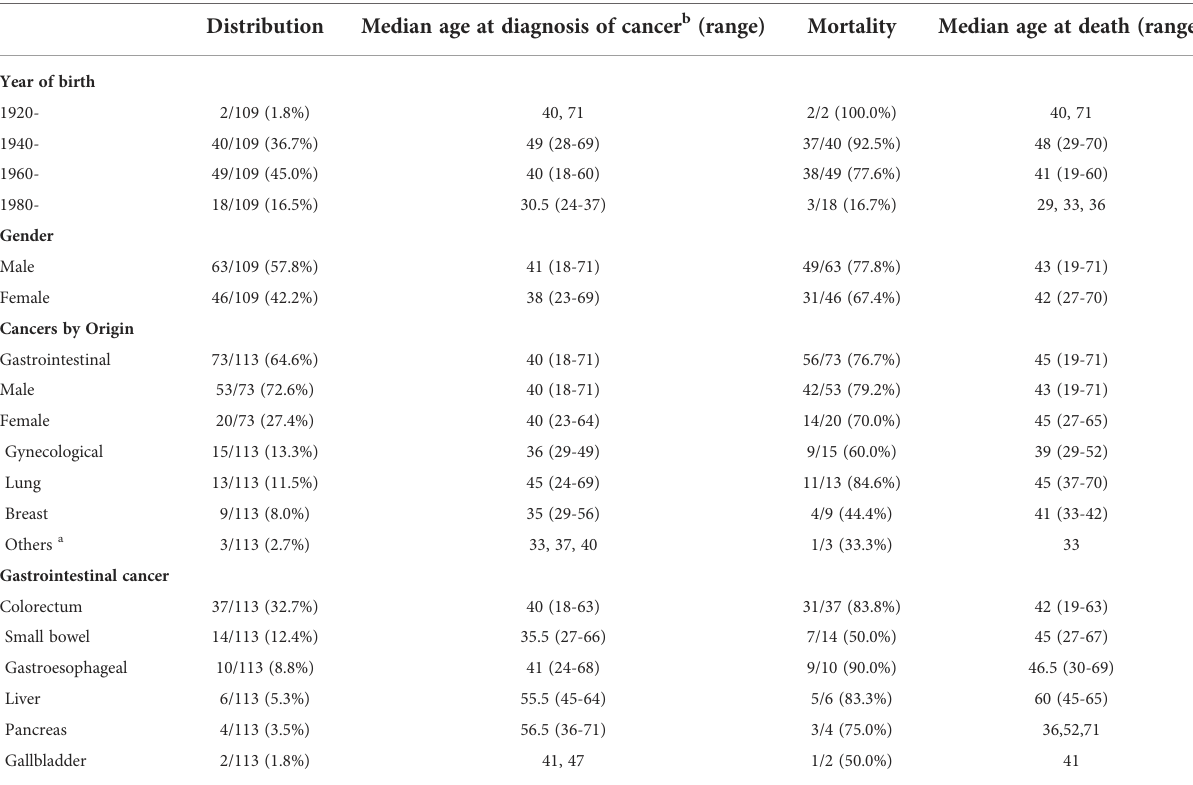
TABLE 2 Characteristics of 113 malignancies in 109 PJS